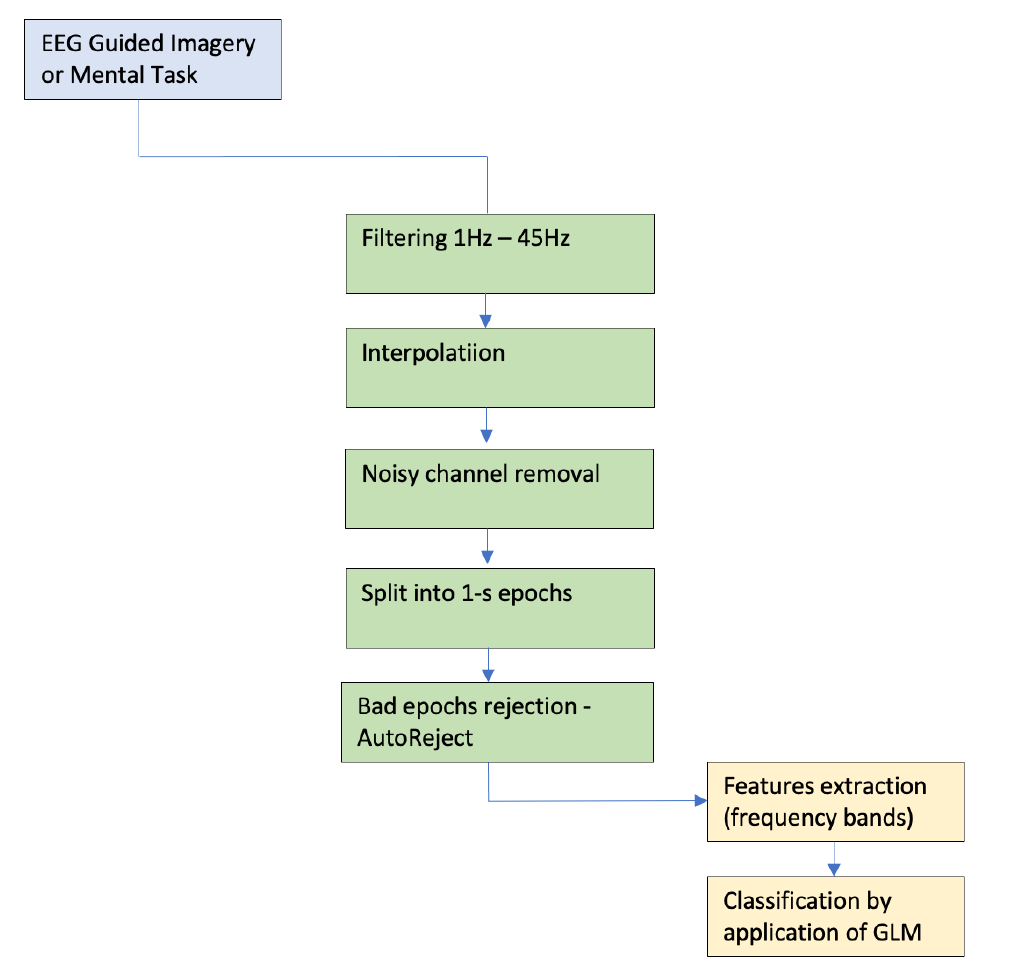
Figure 1. Data analysis pipeline for the experiments. For details, see the